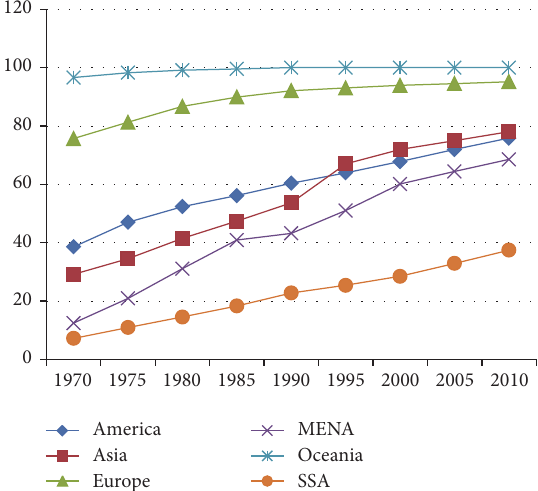
Figure 1: Share of females (15–24) with at least some secondary education (lower secondary education and above), by region. (See Appendix, Figure 5 for a corresponding figure that pertains to share of females (15–24) with at least some primary education, by region.).